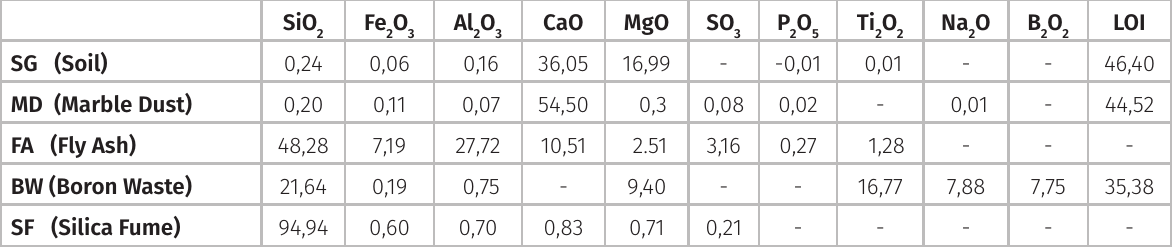
Table I. Chemical characteristics of soil and industrial wastes